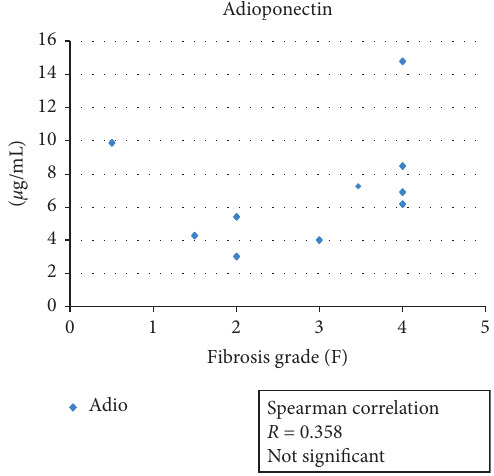
Figure 1: The association between the serum adiponectin level and hepatic fibrosis grade in 10 NAFLD patients with hypopituitarism. Spearman’s correlation was obtained. There was no significant association ( R � 0.358).